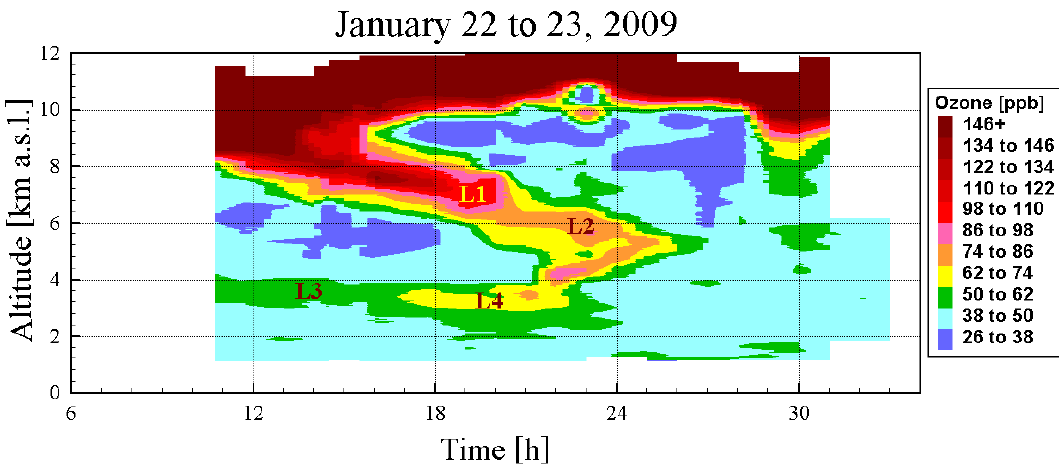
Figure 11. Ozone soundings on 22 and 23 January 2009; four intrusion layers (L1, L2, L3, L4) are identified, corresponding to different advection pathways (see text).